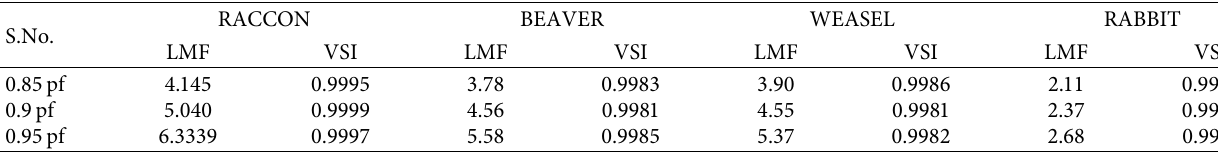
Table 2: Simplifed results of the conductor strength.